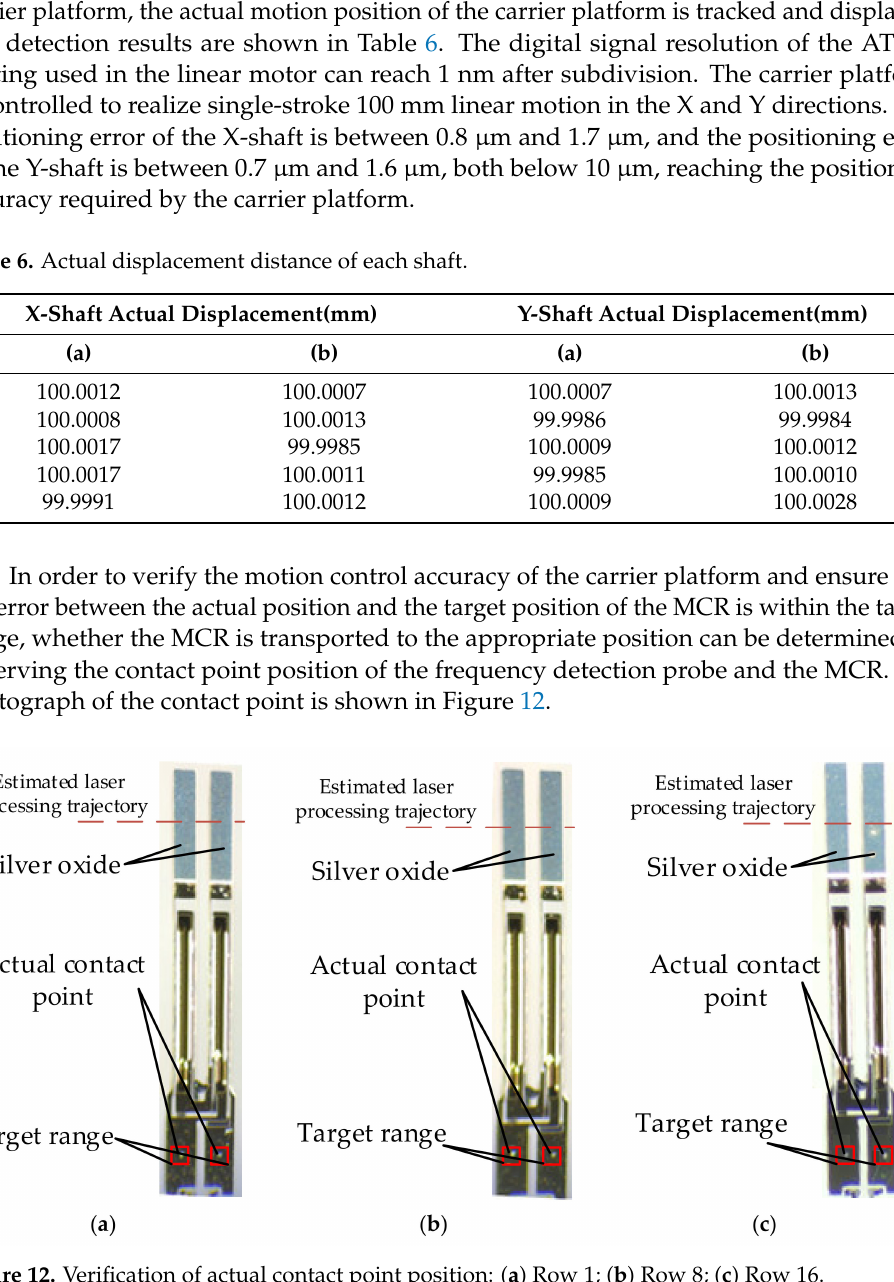
Figure 12. Verification of actual contact point position: ( a ) Row 1; ( b ) Row 8; ( c ) Row